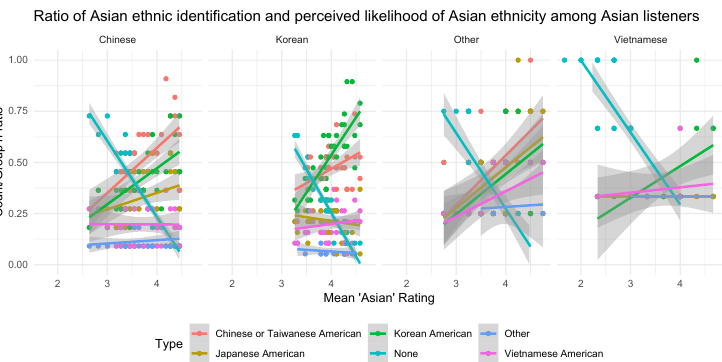
Figure 8. Ratio of the number of times each ethnic category was chosen to the total number of choices made, for Asian listeners only, split by listener ethnic group. Korean listeners (n = 19) were most likely to identify Asian American speakers as specifically Korean American, while Chinese and Taiwanese listeners (n = 11) were more likely to select Chinese or Taiwanese. Vietnamese listeners (n = 3) were not more likely to select Vietnamese, but made no selection at all more often than the other Asian groups. Four listeners in the “Other” category behaved similarly to the Chinese and Taiwanese